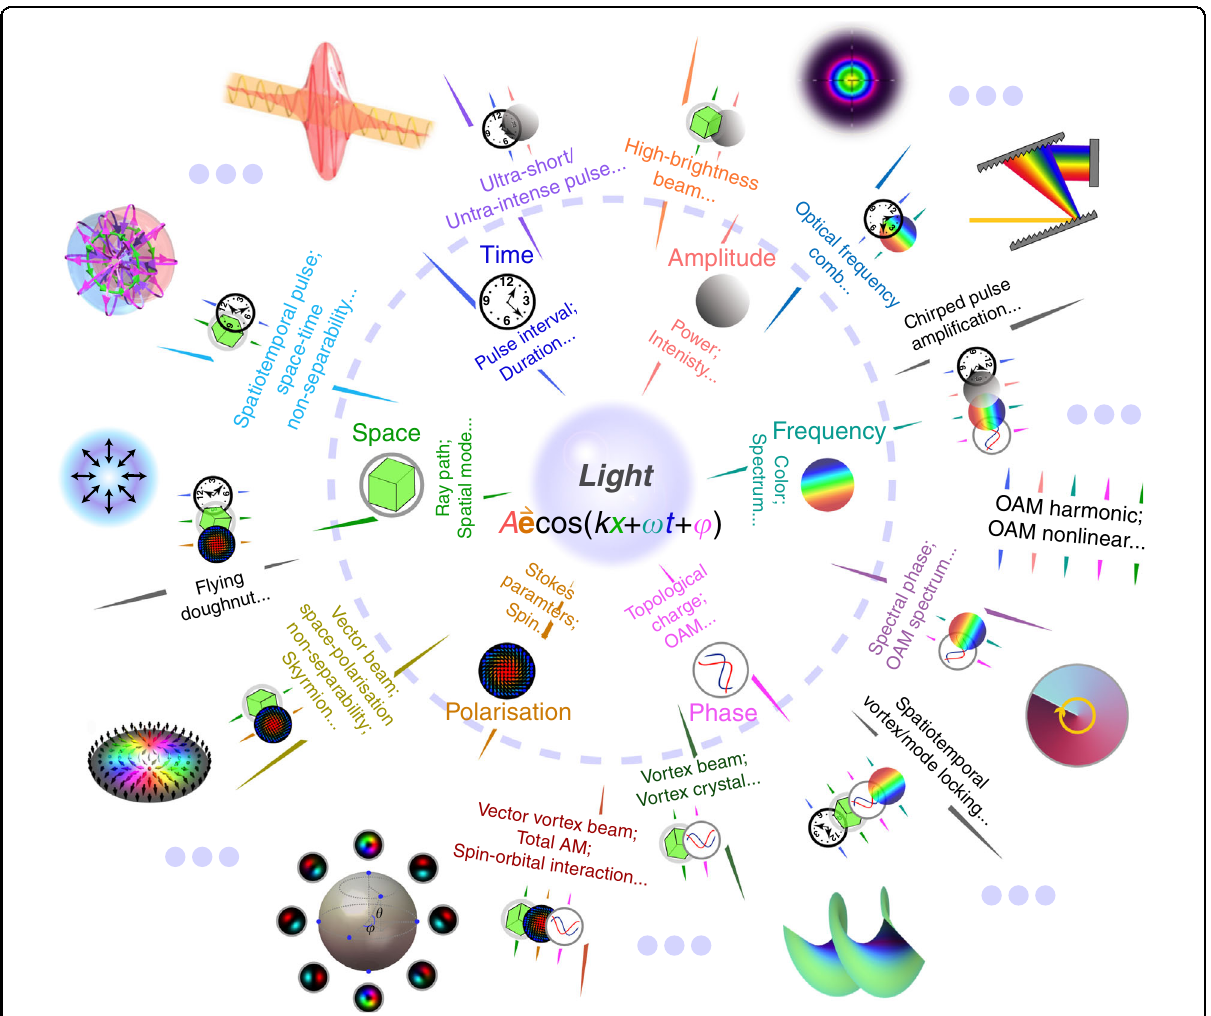
Fig. 1 Light ’ s potential DoFs for control. By tailoring the on-demand structured light distributions of combined DoFs, various non-separable states can be produced so as to pioneer new research fi elds with theoretically unlimited dimensions to explore for structured light